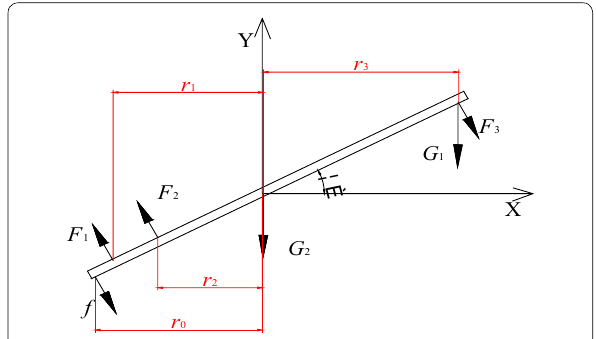
Figure 6 Traditional static-pressure piston rod force